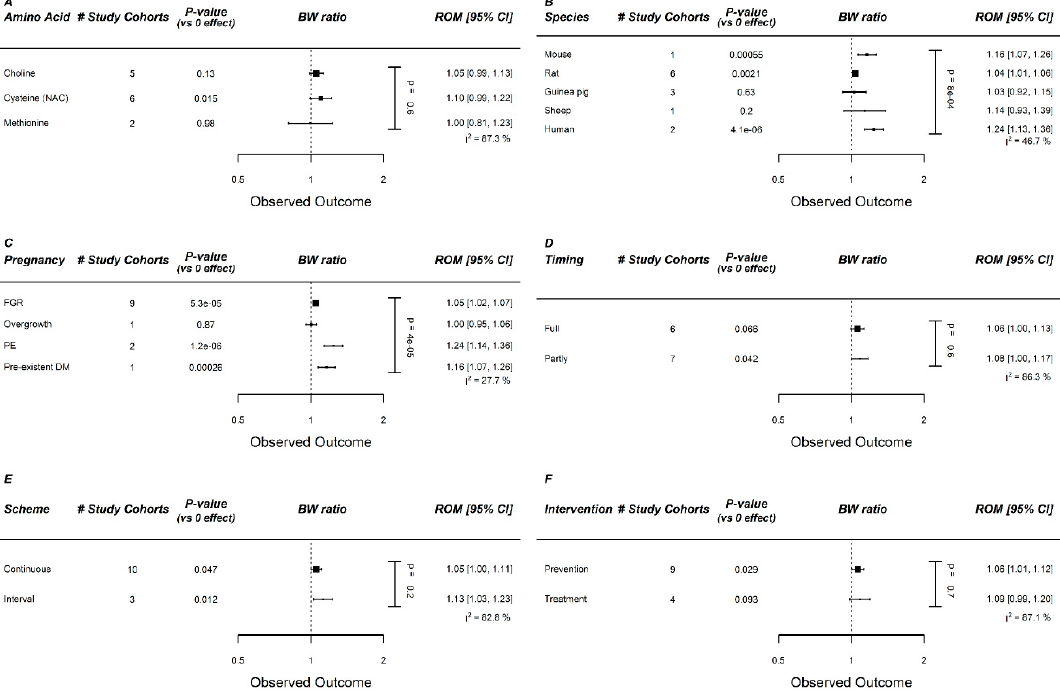
Figure A13. Meta-regression of methyl donors on birth weight (BW). Meta-regression on ( A ) Amino acid (AA); ( B ) species; ( C ) pregnancy complication; ( D ) administration duration; ( E ) administration scheme; ( F ) intervention type (prevention vs. treatment). No specific methyl donor was identified to be the most optimal. Methyl donor supplementation increased birth weight in human and preeclamptic studies (similar studies). Data represent pooled estimates expressed as ratio of means (ROM) with 95% confidence interval (CI) using a random effect model. FGR, fetal growth restriction; I 2 , heterogeneity; PE, preeclampsia; PIH, pregnancy-induced hypertension.